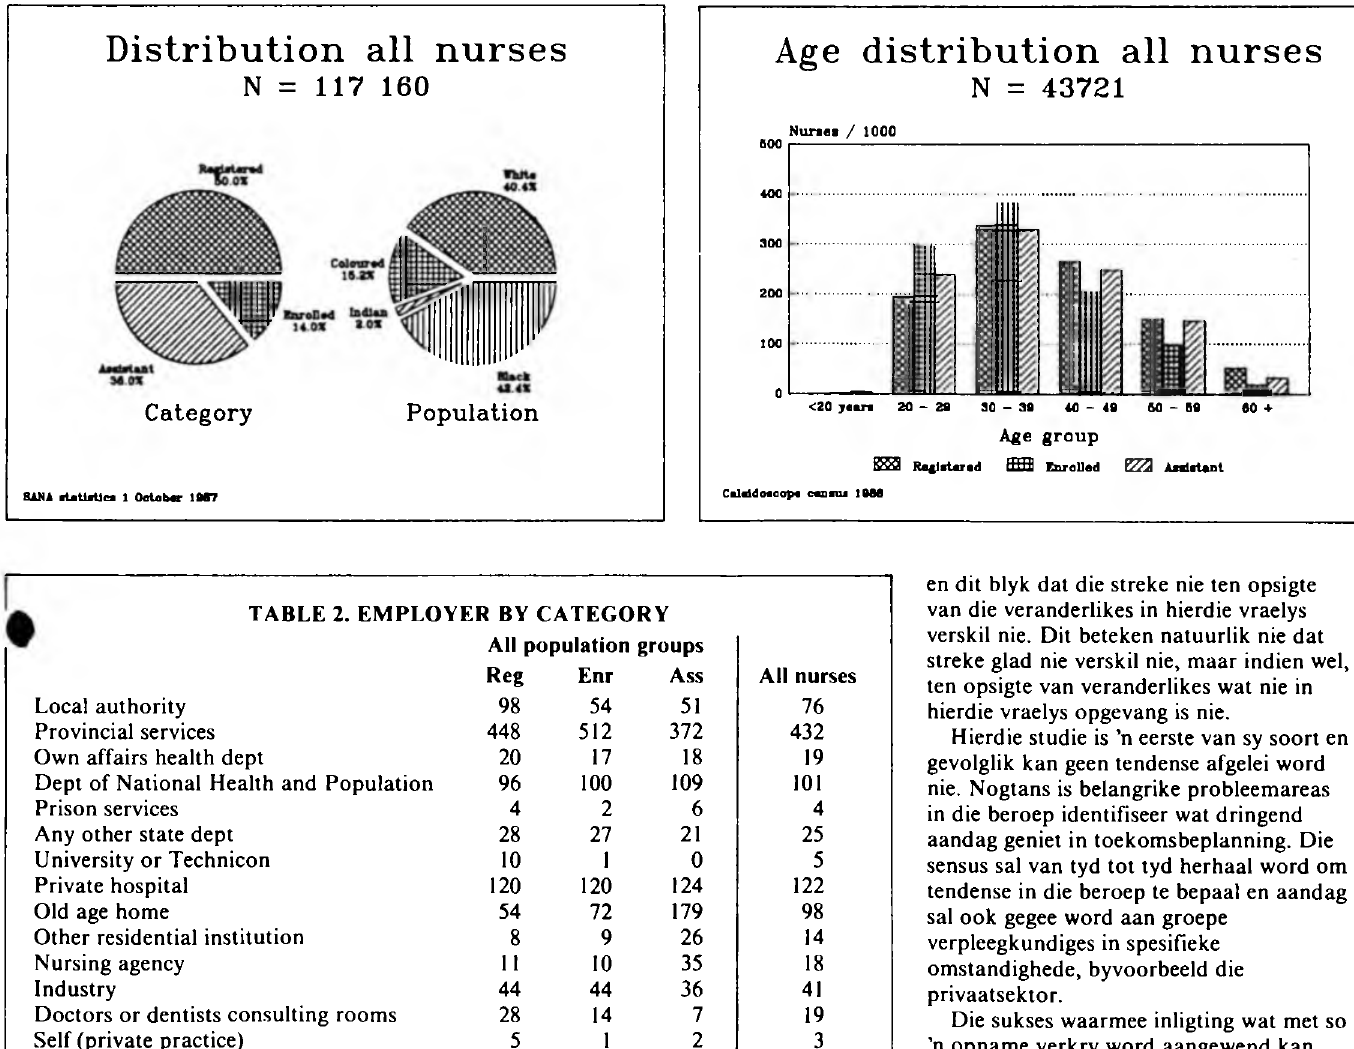
TABLE 2. EMPLOYER BY CATEGORY All population